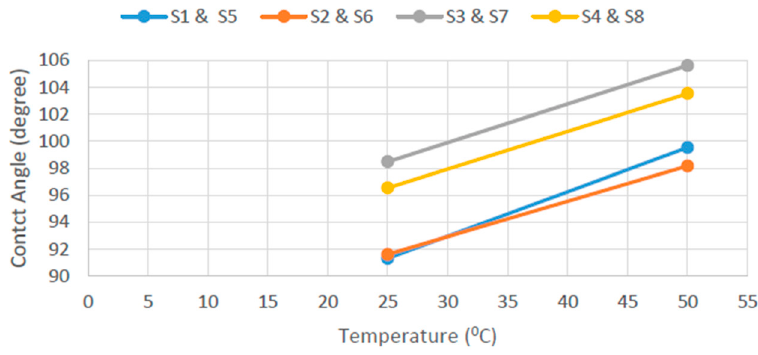
Figure 4. Contact angle variation in eight samples with increase in temperature for brine B1.